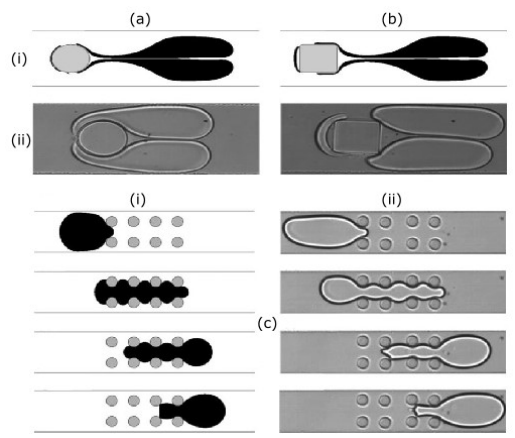
Figure 8. Droplet passing through the obstacles: ( a ) single cylinder; ( b ) single square; and, ( c ) array of cylinders; (i) numerical results; (ii) experimental results. Adapted with permission from [92].